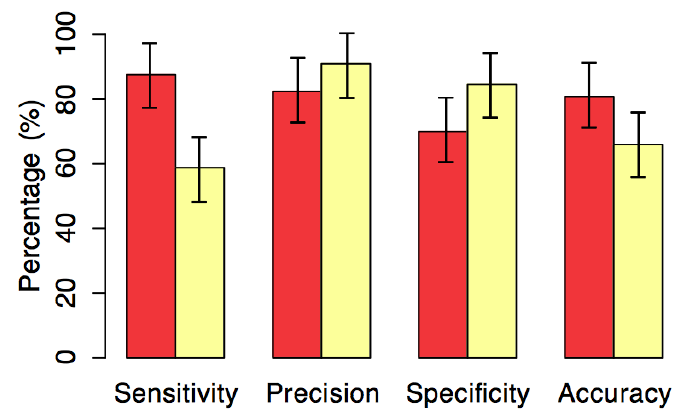
Figure 11. Evaluation of the results obtained by